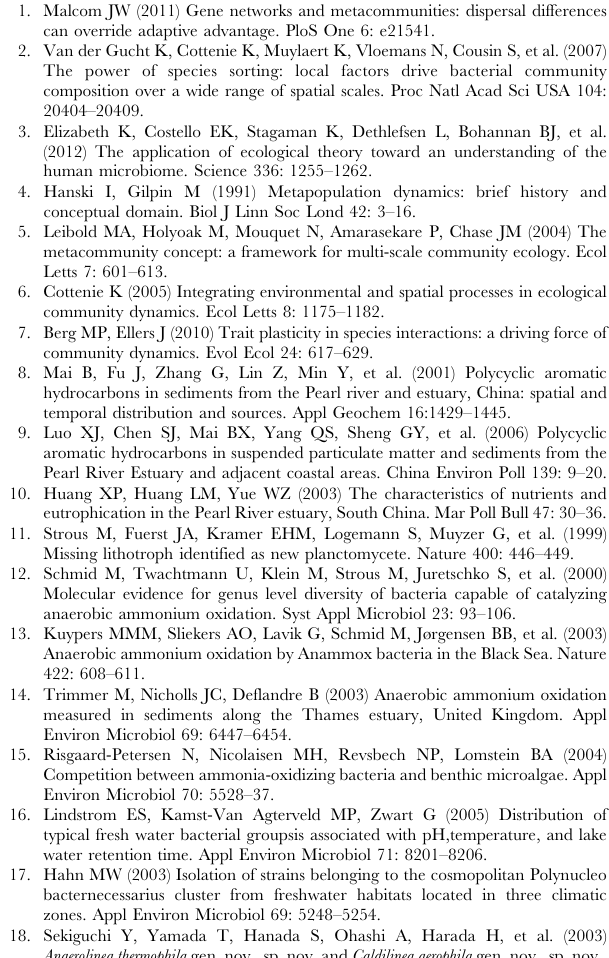
Figure S1 Rarefaction curves for microbial communities in the surface sediment and overlying water from the Pearl River Estuary from (a) summer and (b) winter. Rarefaction is shown for OTUs at a dissimilarity level of 3%. See Table 1 and Figure 2 for the sample identifiers. Figure S2 Heat map showing the relative abundance and distribution of representative 16S rRNA tagged sequences classified at the genus level. The normalized data were clustered using the complete linkage method and a metric of correlation (uncentered). The color code indicates the difference in relative abundance from the mean, ranging from green (-ve), to black (mean) and to red ( + ve). See Table 1 and Figure 2 for the sample identifiers.